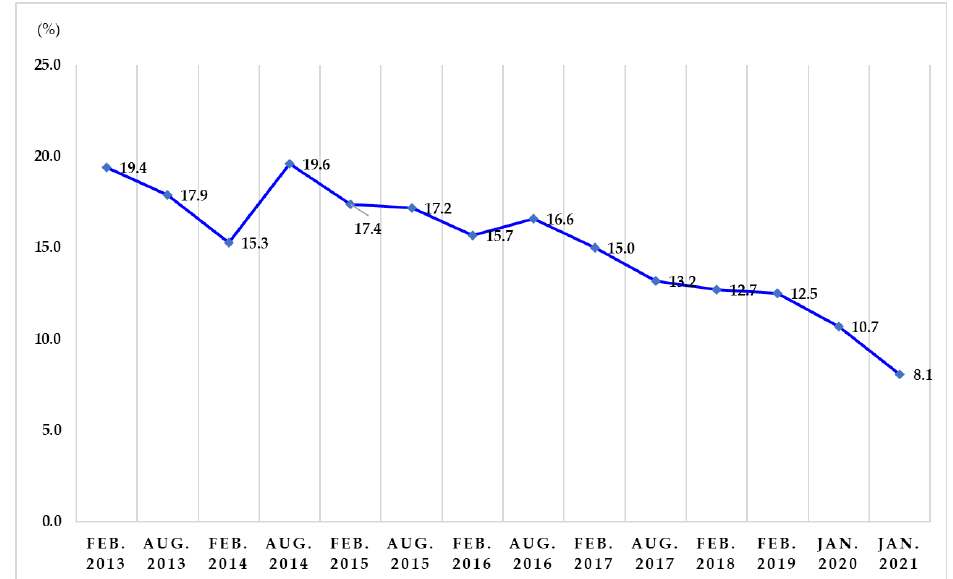
Figure 1. Trends in avoidance of foods produced in Fukushima Prefecture.